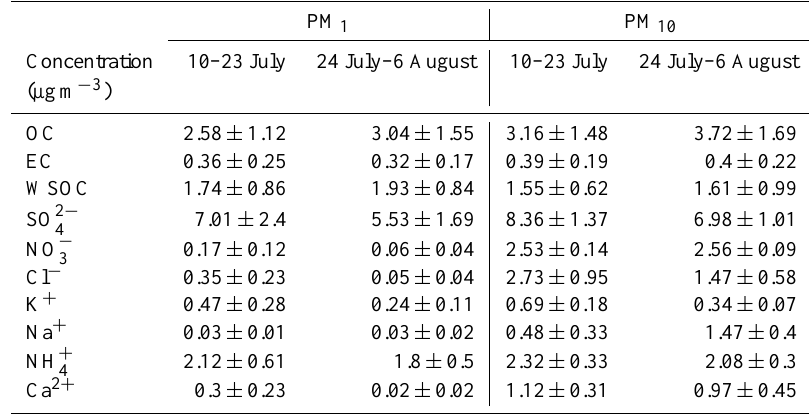
Fig. 5. Examples of daily average CCN distributions from 2 August at different levels of supersaturation. Table 1. Average concentrations for organic components and major ions for PM 1 and PM 10 . PM 1 PM